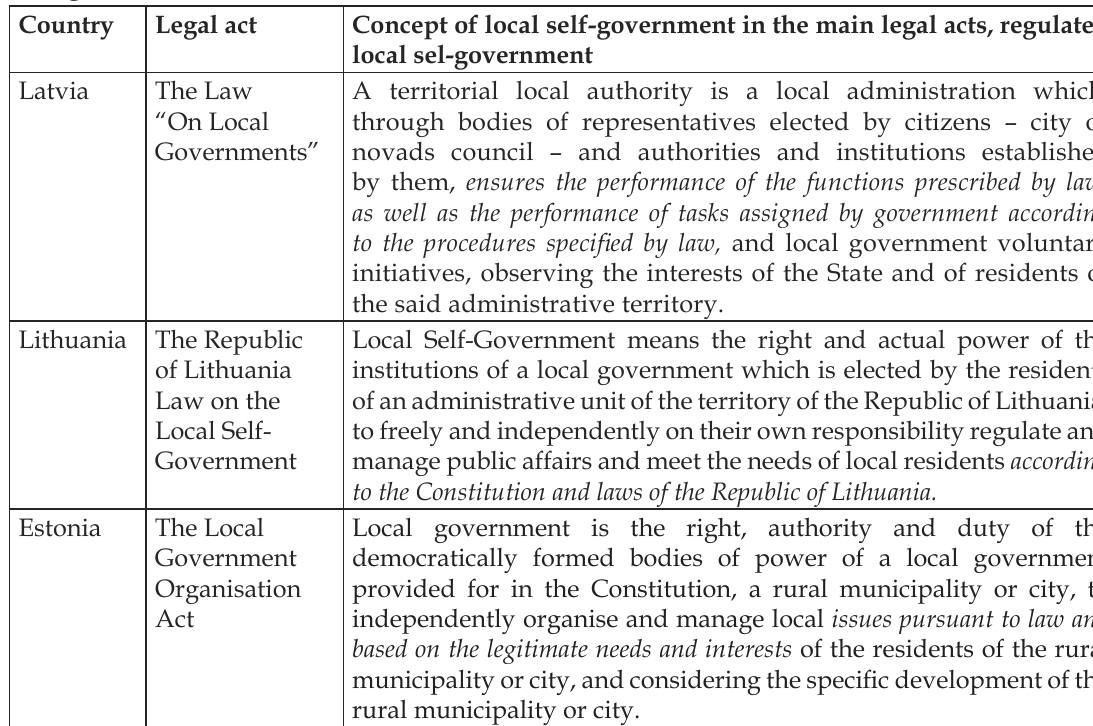
Tab. 2. Concepts of local self-government in the main legal acts, regulated local